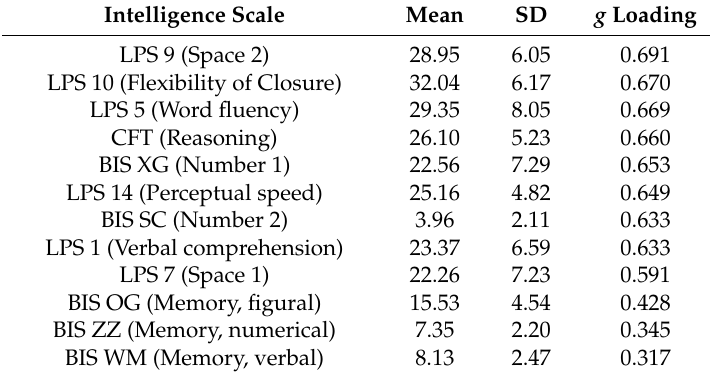
Table 2. Mean and standard deviation (SD) of the unstandardized scores on the six subtests of the Leistungsprüfsystem (LPS), the five subtests of the Berlin Intelligence Structure Test (BIS), and Cattell’s Culture Fair Test (CFT) as well as g loadings of each